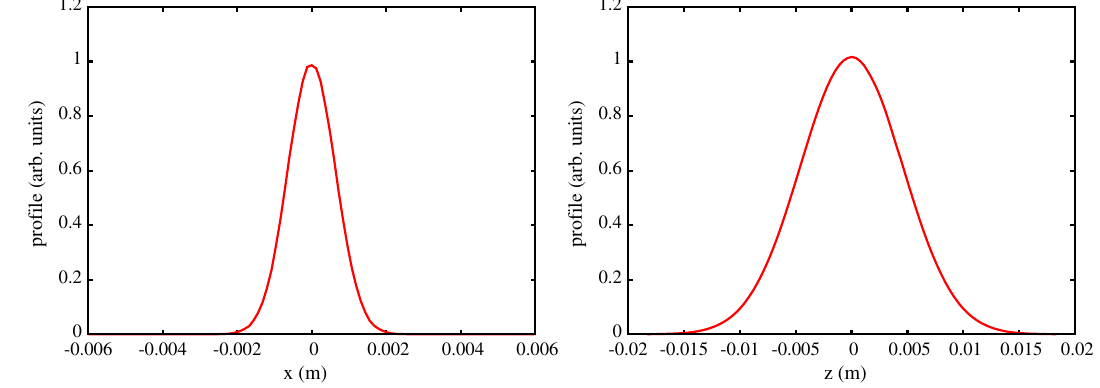
FIG. 6. The transverse (left) and longitudinal (right) density profiles of a 3D bunched beam.